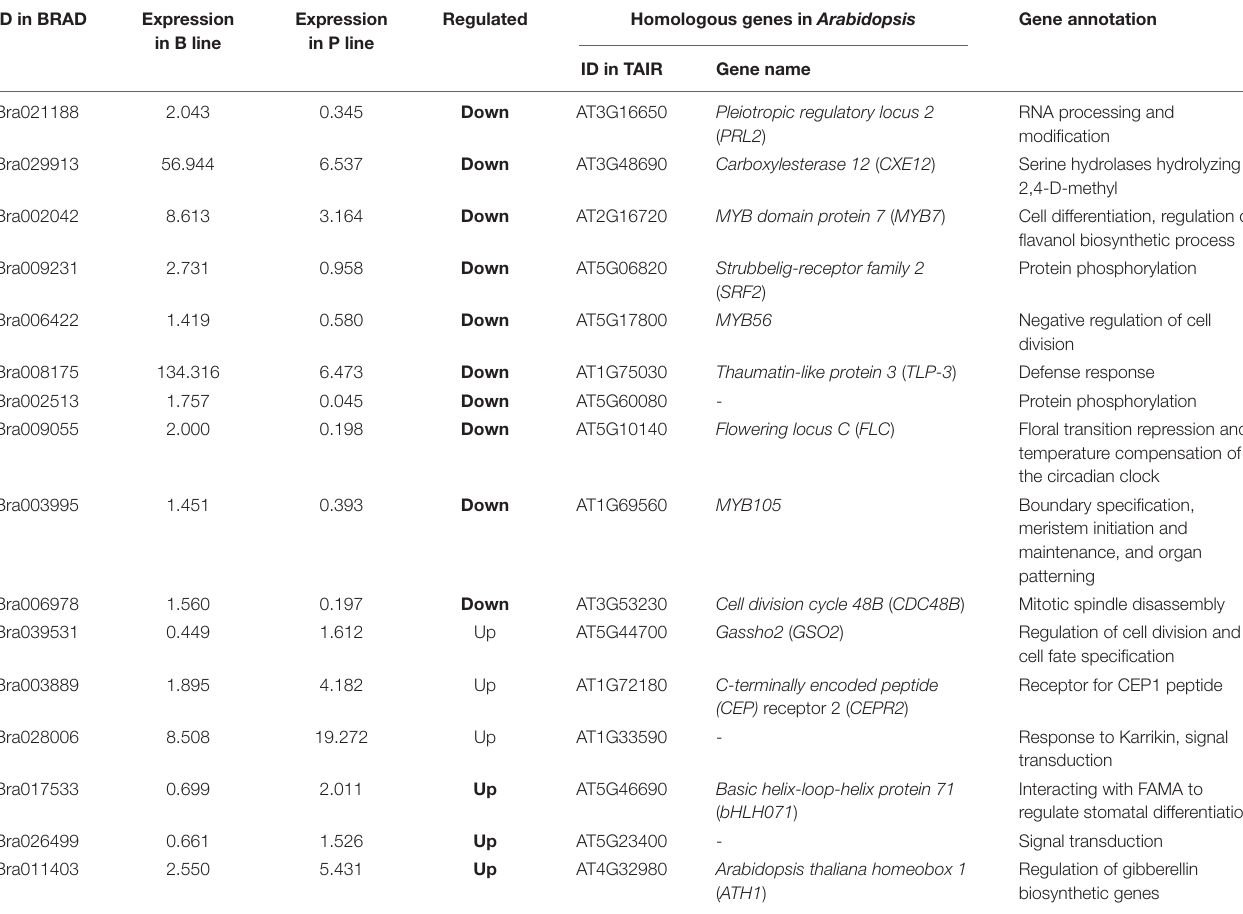
TABLE 1 | Common DEGs between Polima cytoplasmic male-sterile of Brassica campestris and the Arabidopsis spl/nzz mutant. ID in BRAD Expression in B